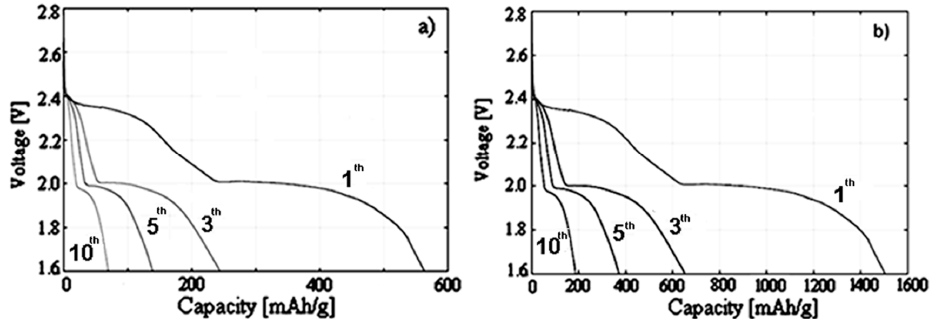
Figure 9. ( a ) Discharge curves at theoretical capacity (C)/10 for CS material; ( b ) discharge curves at C/10 for SDR material.